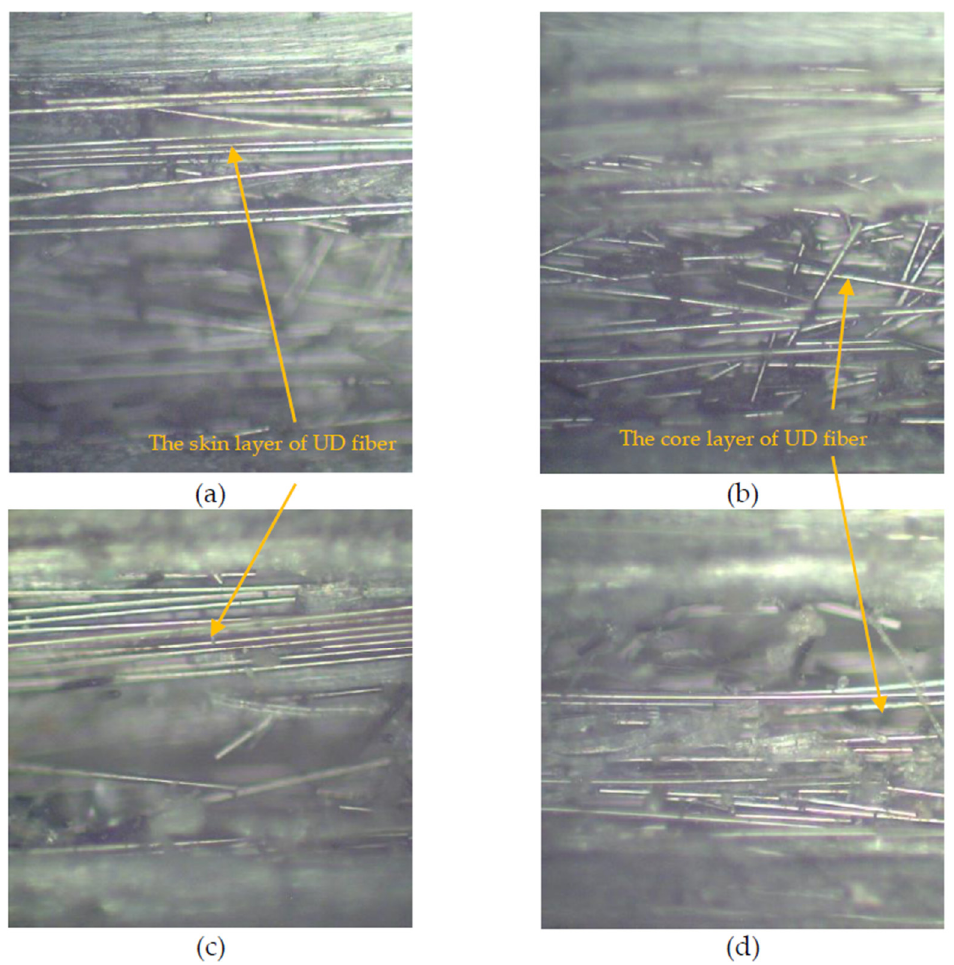
Figure 16. Longitudinal cross section of ( a ) non-pre tensioned fiber at skin layer; ( b ) non-pre tensioned fiber at the core; ( c ) pre-tensioned fiber at skin layer; and ( d ) pre-tensioned fiber at the core.